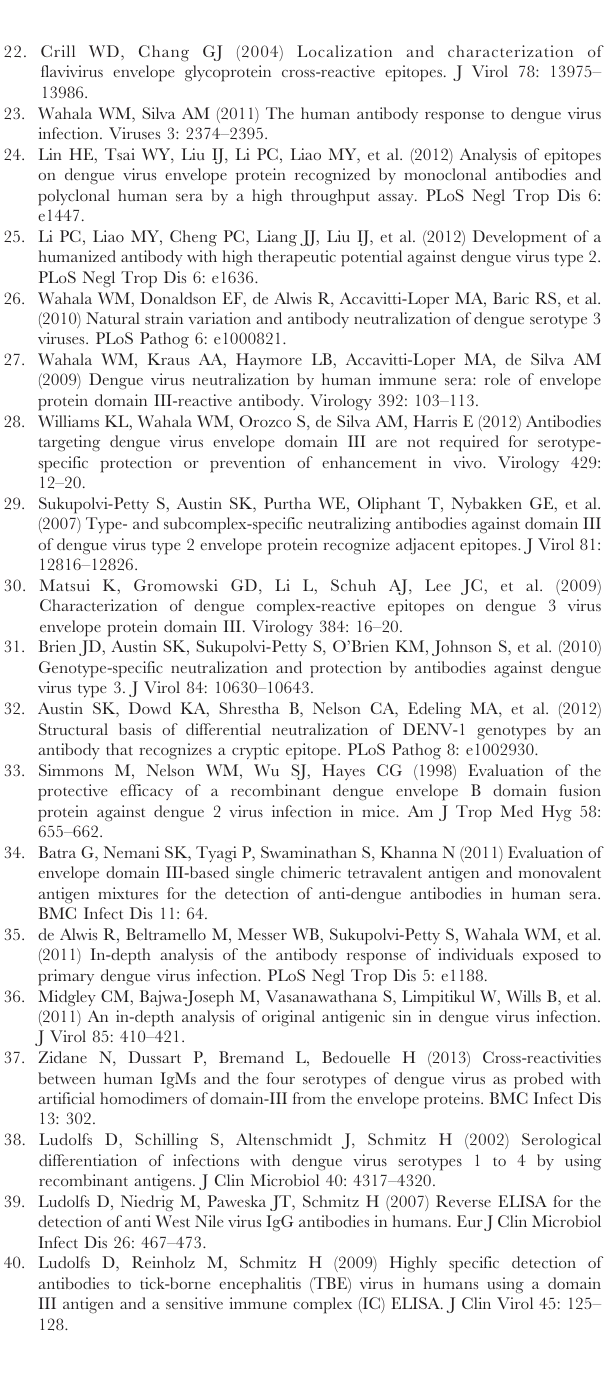
Table S1 Intra- and inter-assay variation of DENV EDIII 1-4 ICB ELISAs. (PDF) Table S2 OD values used for figure 2. (PDF) Table S3 Antibody kinetics of four patients with DENV-1, -2, or -3 infection. Shown are the OD values used for figure 4. (PDF) Table S4 P/N data for 12 Vietnamese subjects with supposed secondary DENV infections.